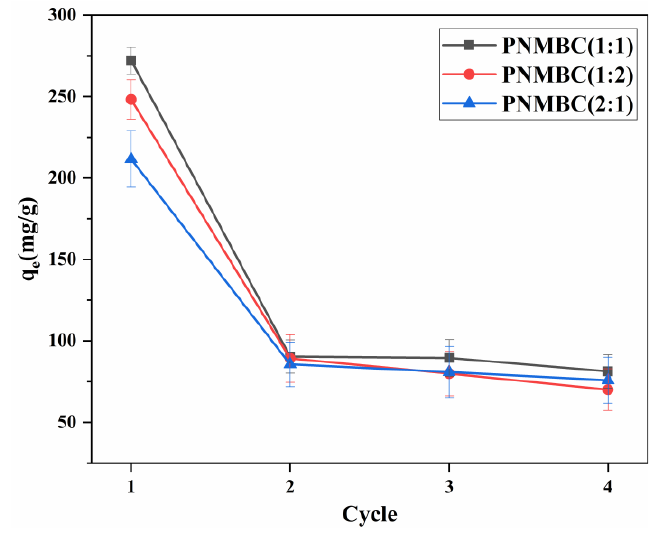
Figure 14. Adsorption–desorption cycles for Cu(II) removal by